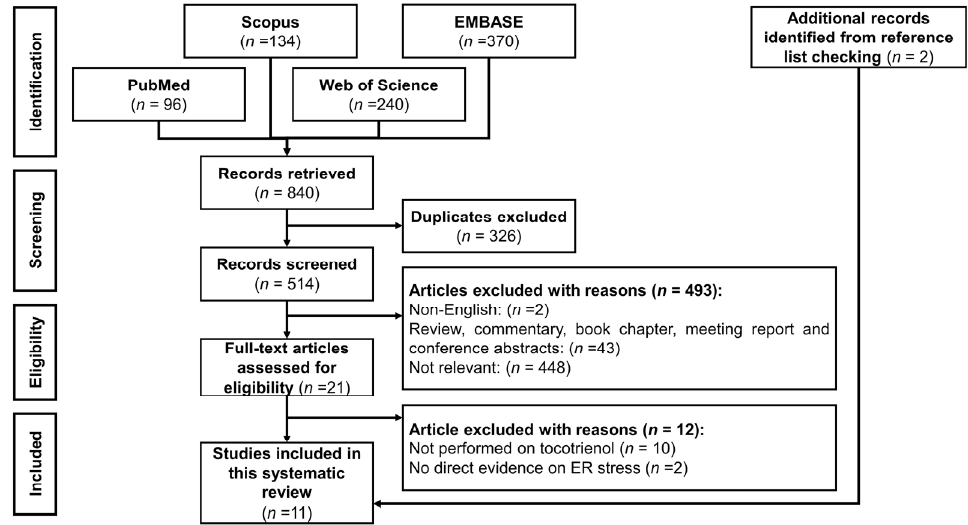
Figure 3. PRISMA fl ow chart of the systematic review. Figure 3. PRISMA flow chart of the systematic